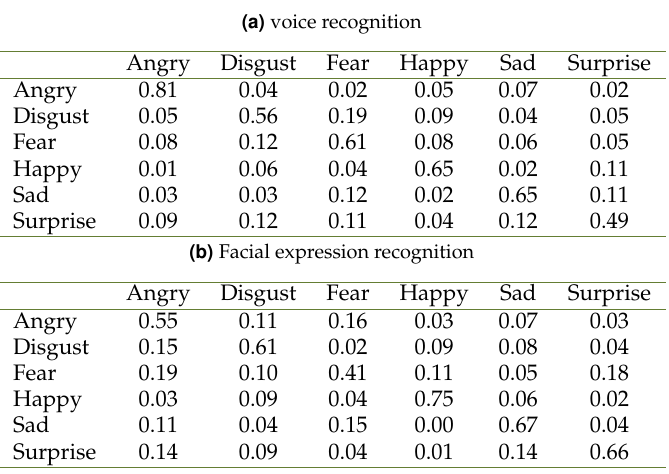
Table 1. Single-modal emotion recognition accuracy in terms of confusion matrix (a) voice recognition